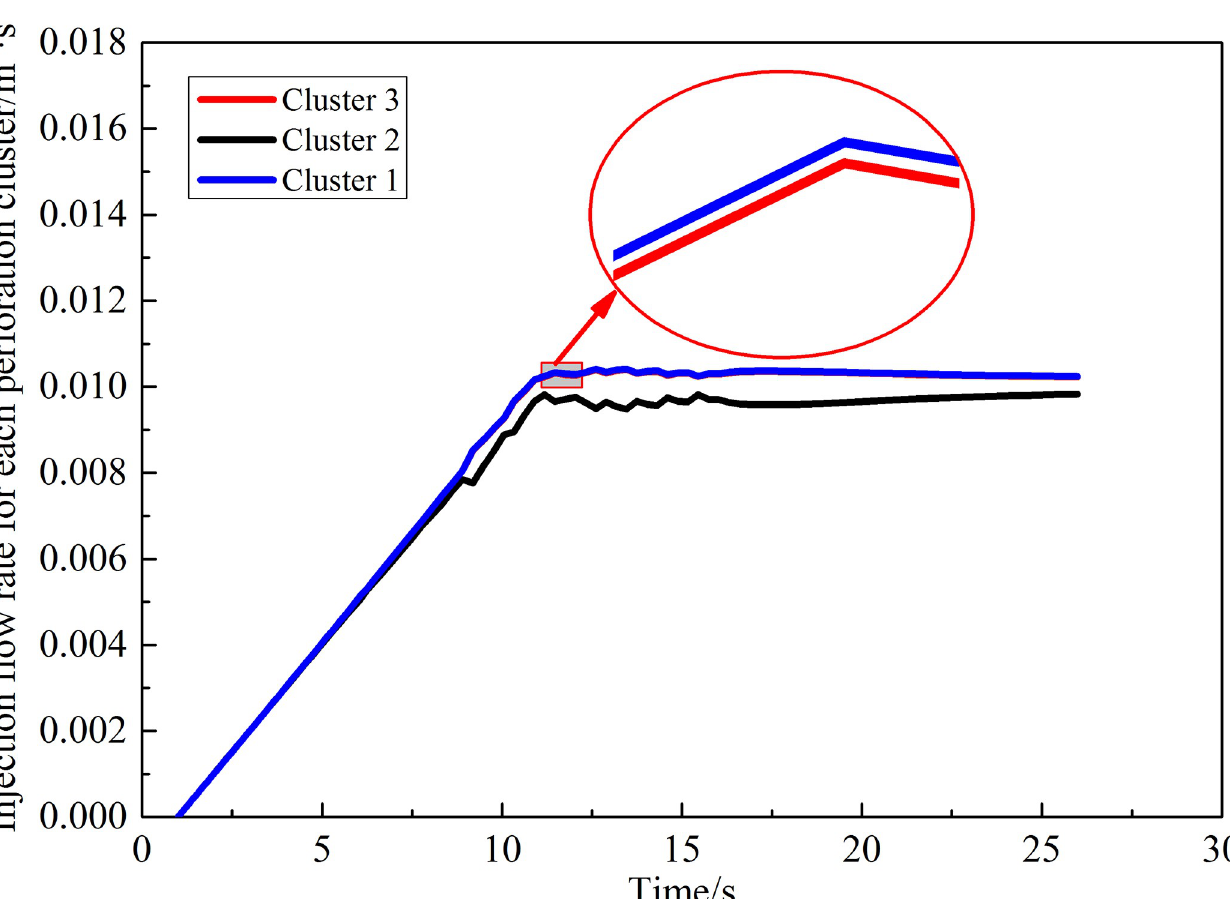
Fig 20. Quantity of flow distribution between clusters after